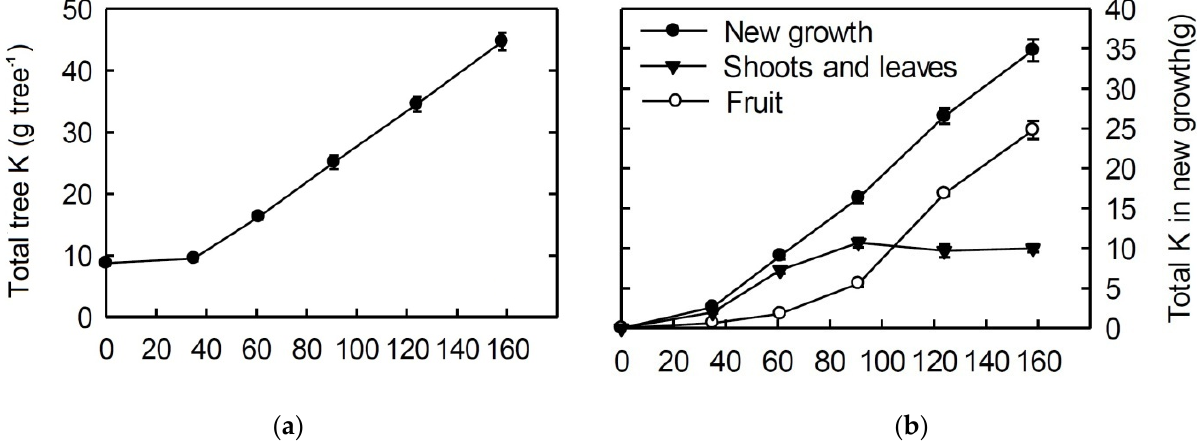
Figure 1. Total K accumulation in the entire tree ( a ) and in new growth ( b ) of 6-year-old ‘Gala’/M.26 trees grown in sand culture under a complete nutrient supply regime. The six points correspond with bud break, bloom, end of spur leaf growth, end of shoot growth, rapid fruit expansion period, and fruit harvest, respectively [28].